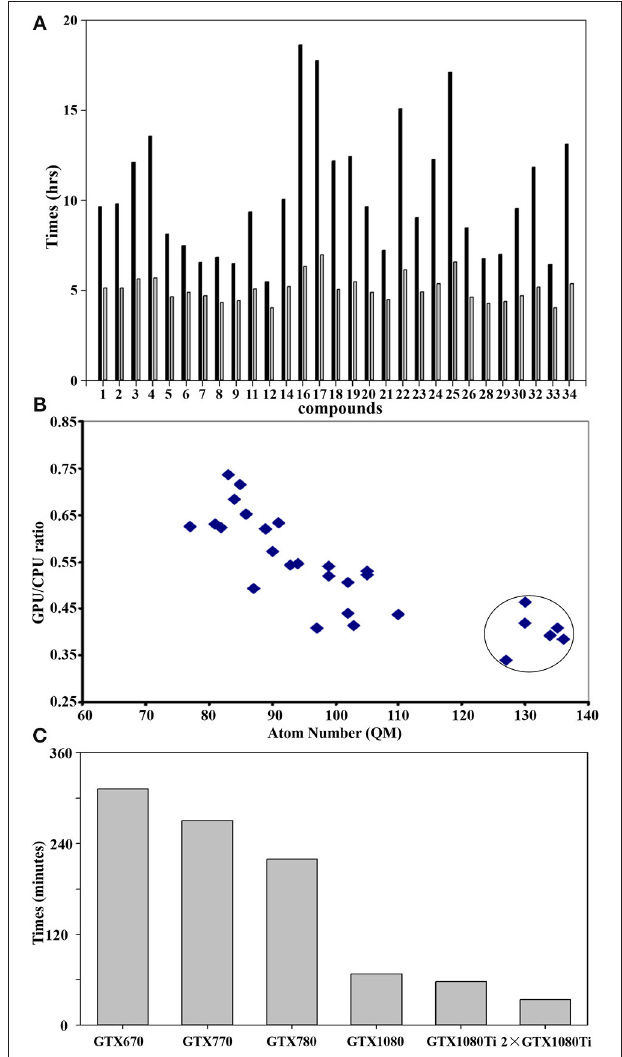
FIGURE 5 | GPU accelerated performance of quantum mechanical calculations. (A) Comparison of performance of QM/MM optimization between CPU and GPU using Guassian09 and teraChem for the best docked conformation of the compounds as listed in Table 1 . The x-axis sequence corresponds to the compound list in Table 1 ; (B) Correlation of GPU/CPU ratio (speedups) of the best docked conformation for each compound as function of atom numbers in the QM region. The speedups for the large size of QM region ( > 120 atoms) are circled. (C) Computer time (in minutes) required for a single QM calculation using teraChem as function of the GPU unit model. Currently, the most advanced GTX is GTX